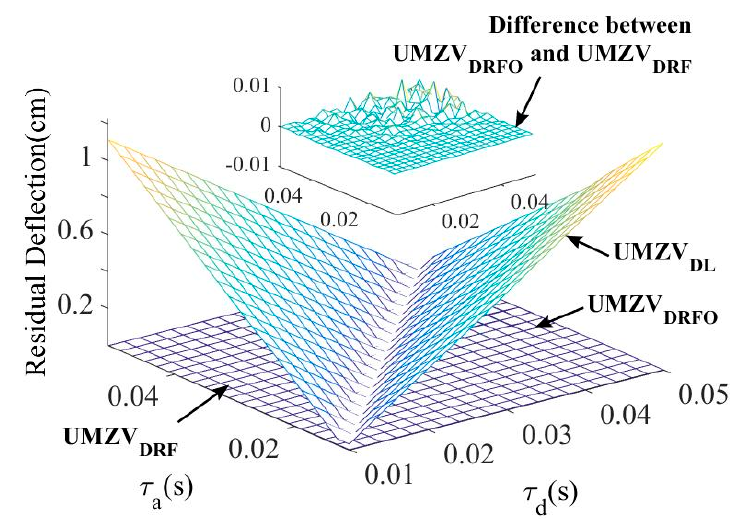
Figure 8. Residual deflection to τ a and τ d .